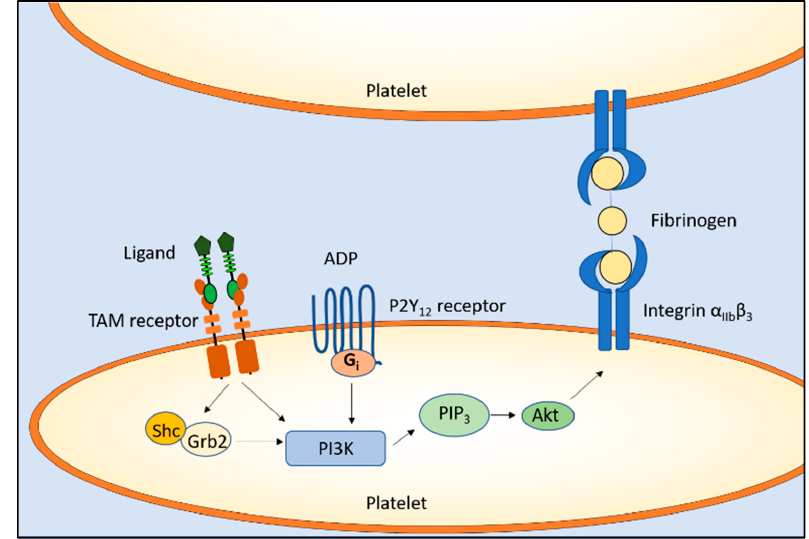
Figure 1. Function of Tyro3, Axl, and Mer (TAM) receptors in hemostasis. In platelets, the activation of TAM receptors and the adenosine diphosphate (ADP) receptor (P2Y 12 ) leads to the phosphorylation of phosphoinositide 3 kinase (PI3K) and Akt, resulting in persistent activation of the fibrinogen receptor integrin α IIb β 3 and leading to thrombogenesis and platelet stabilization.